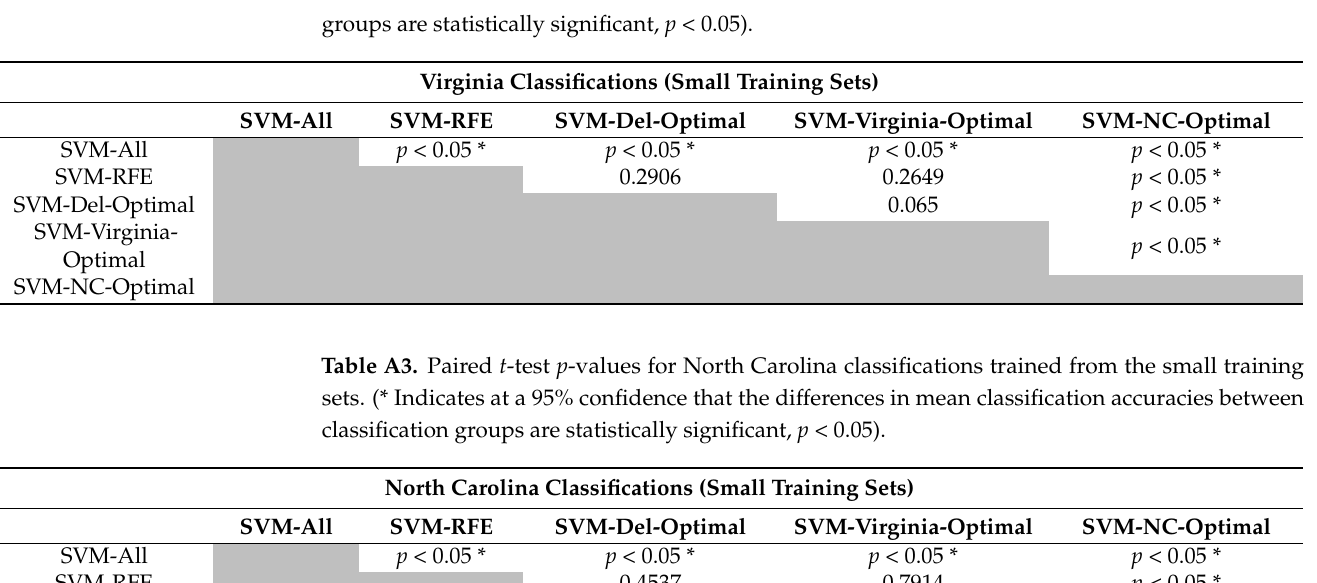
Table A2. Paired t -test p -values for Virginia classifications trained from the small training sets. (* Indi- cates at a 95% confidence that the differences in mean classification accuracies between classification groups are statistically significant, p < 0.05).